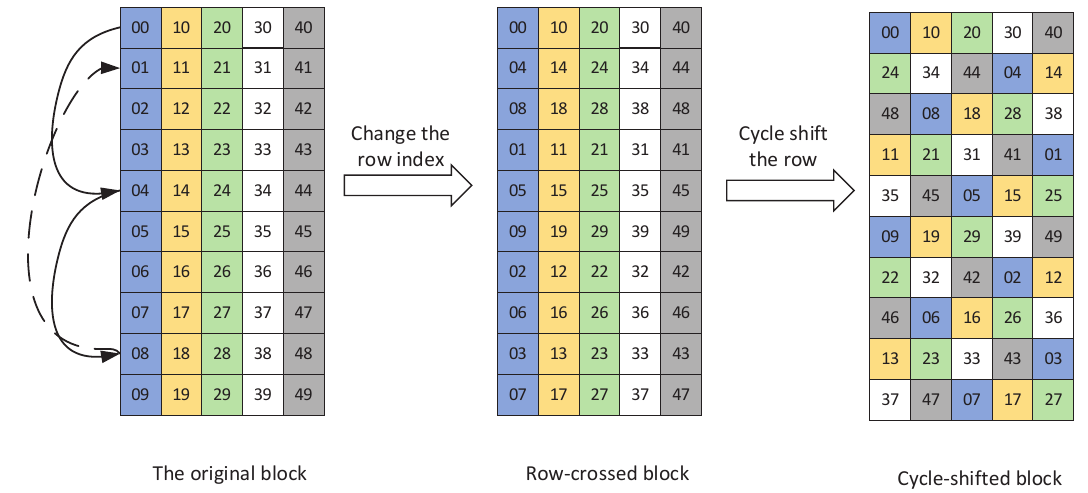
Figure 4. Schematic diagram of CRCSI.